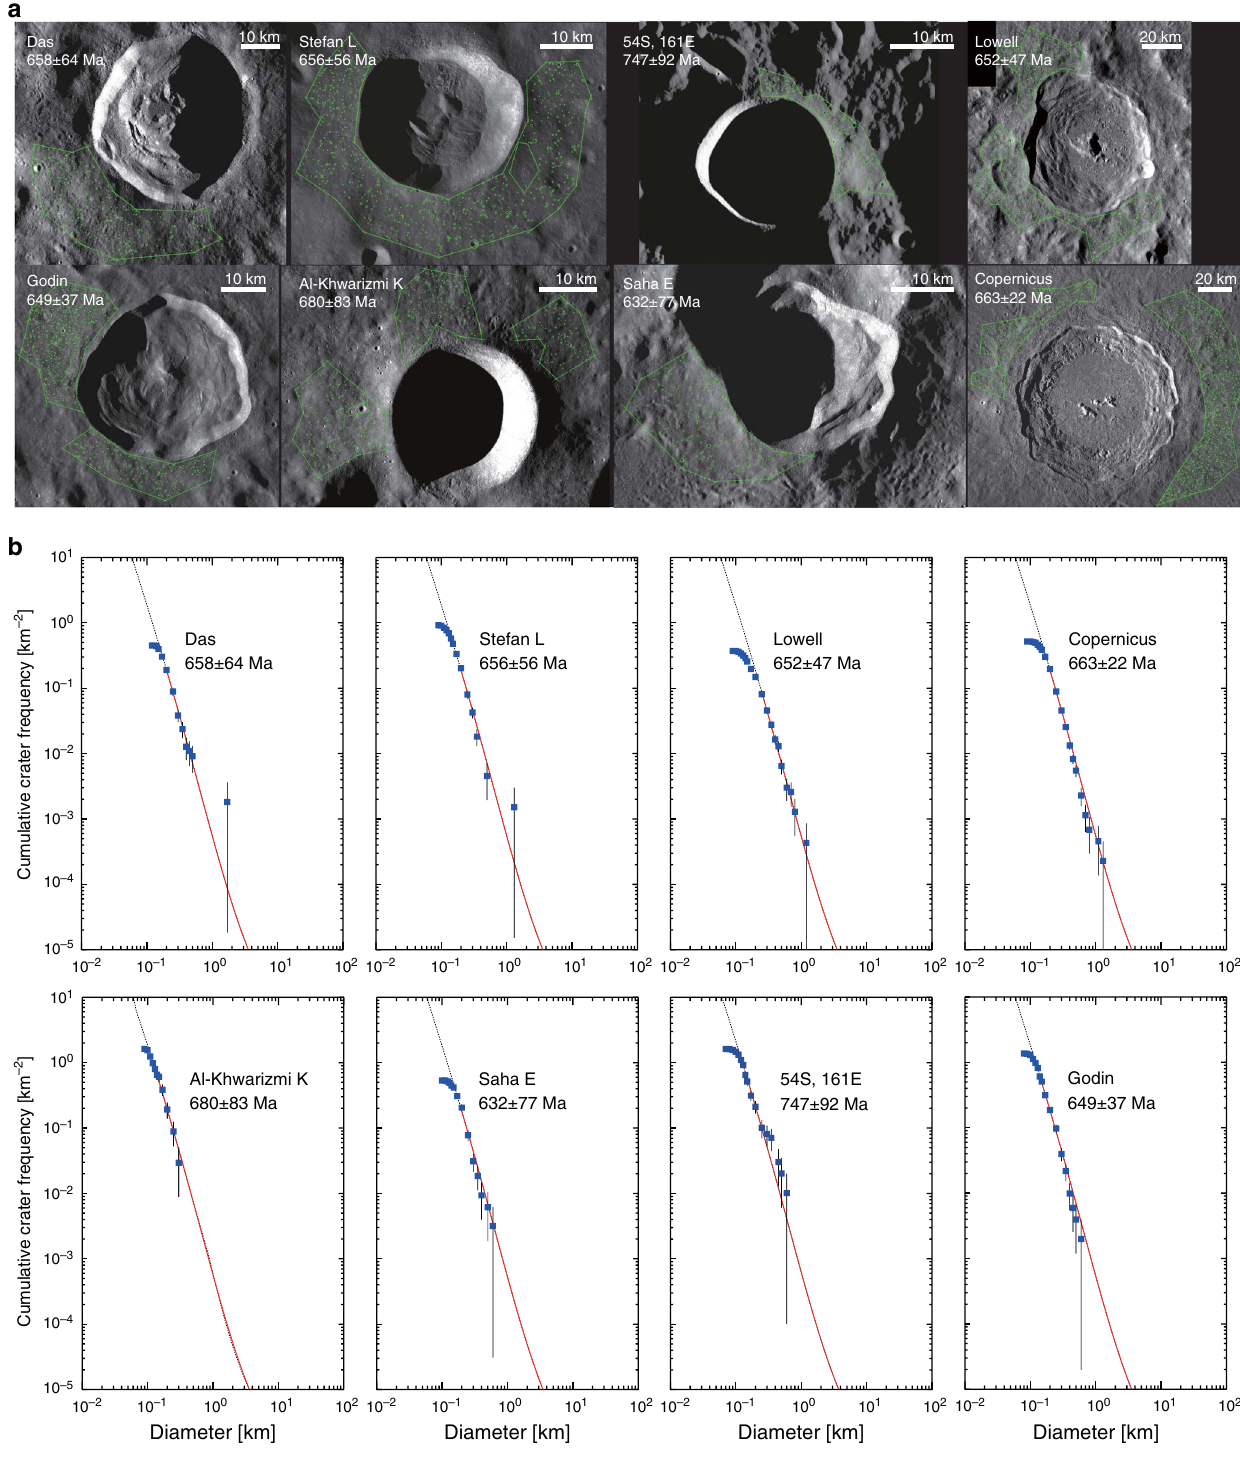
Fig. 2 The Terrain Camera images of individual craters and their cumulative size-frequency distributions, for which ages are identical to that of Copernicus crater. a Mosaics of the Terrain Camera images of individual craters shown in simple cylindrical map projection and b the cumulative size- frequency distributions, from which ages are identical to that of Copernicus crater. The small craters around the central main crater are counted for the determination of the central crater itself. b Shows their cumulative size-frequency distributions. Error bars are estimated by the formula ( n ± n 1/2 )/ A , where n is the cumulative number of craters and A is the counted